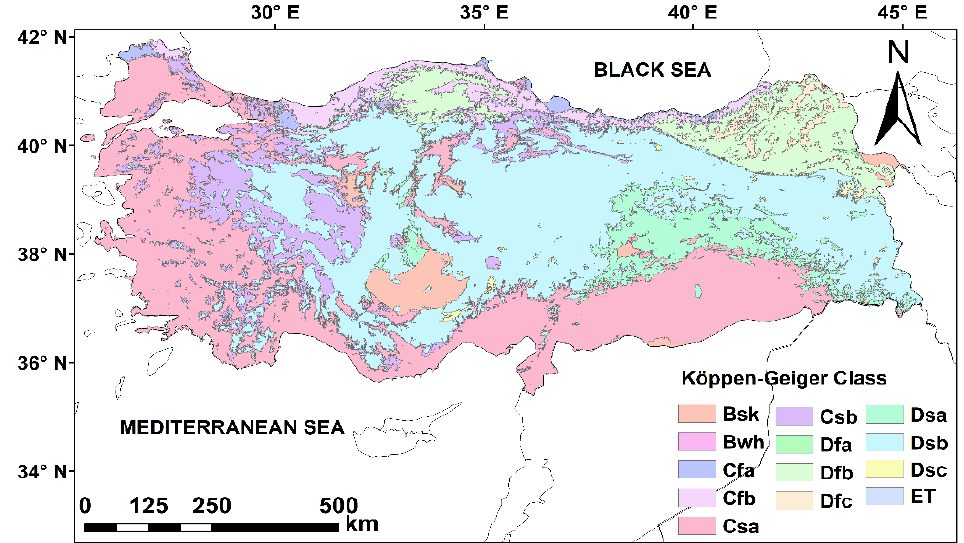
Figure 2. The Köppen–Geiger climate classification for Turkey. BSk: arid steppe cold; Bwh: arid desert hot; Cfa: temperate without dry season, hot summer; Cfb: temperate without dry season, warm summer; Csa: temperate, dry summer, hot summer; Csb: temperate, dry summer, warm summer; Dfa: cold without dry season, hot summer; Dfb: cold without dry season, warm summer; Dfc: cold without dry season, cold summer; Dsa: cold, dry summer, hot summer; Dsb: cold dry season warm summer; Dsc: cold, dry season, cold summer; ET: polar tundra [42].